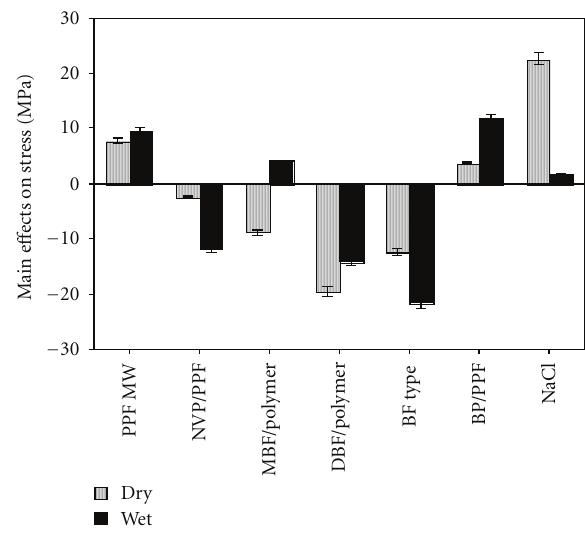
Figure 4: The main e ff ects of the parameters on the ultimate strength of the crosslinked PPF composites. A positive number indicates an increase in the strength as the parameter was changed from a low ( − ) level to a high (+) level. A negative number indicates a decrease in the strength as the parameter was changed from a low ( − ) level to a high (+) level. Error bars represent the standard error of the e ff ect (dry ± 16.5 MPa, wet ± 6.2